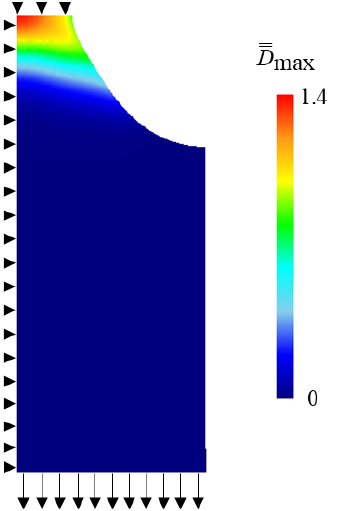
Figure 10. Distribution of the maximum principal damage value at fracture in the uniaxial tensile test of notched round bar specimen (No.4 in Table 2).